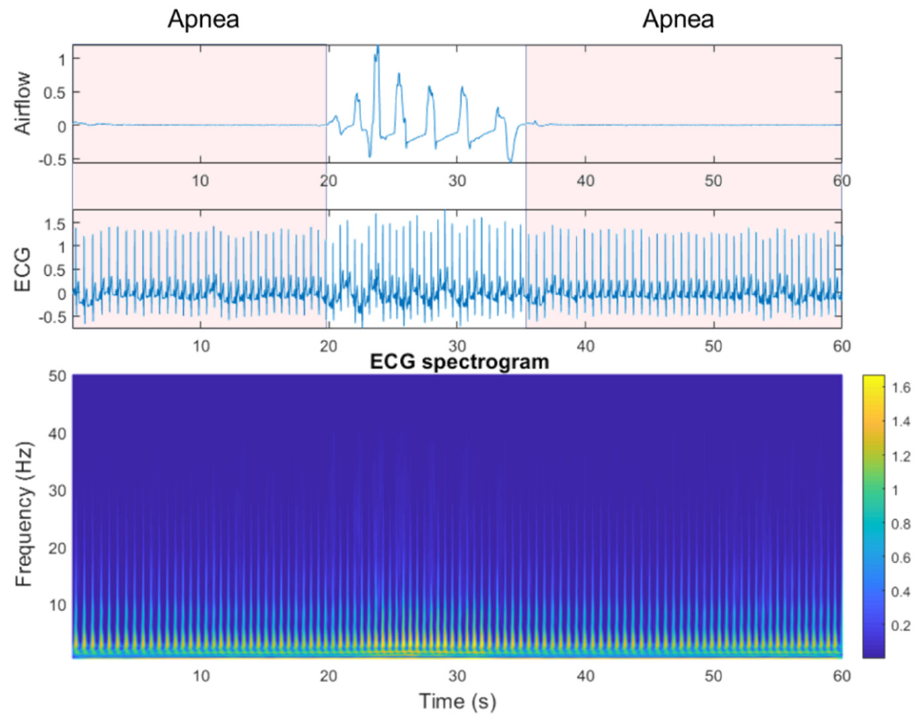
Figure 2. Airflow, electrocardiogram (ECG), and ECG spectrograms from apnea to non-apnea, followed by apnea again.